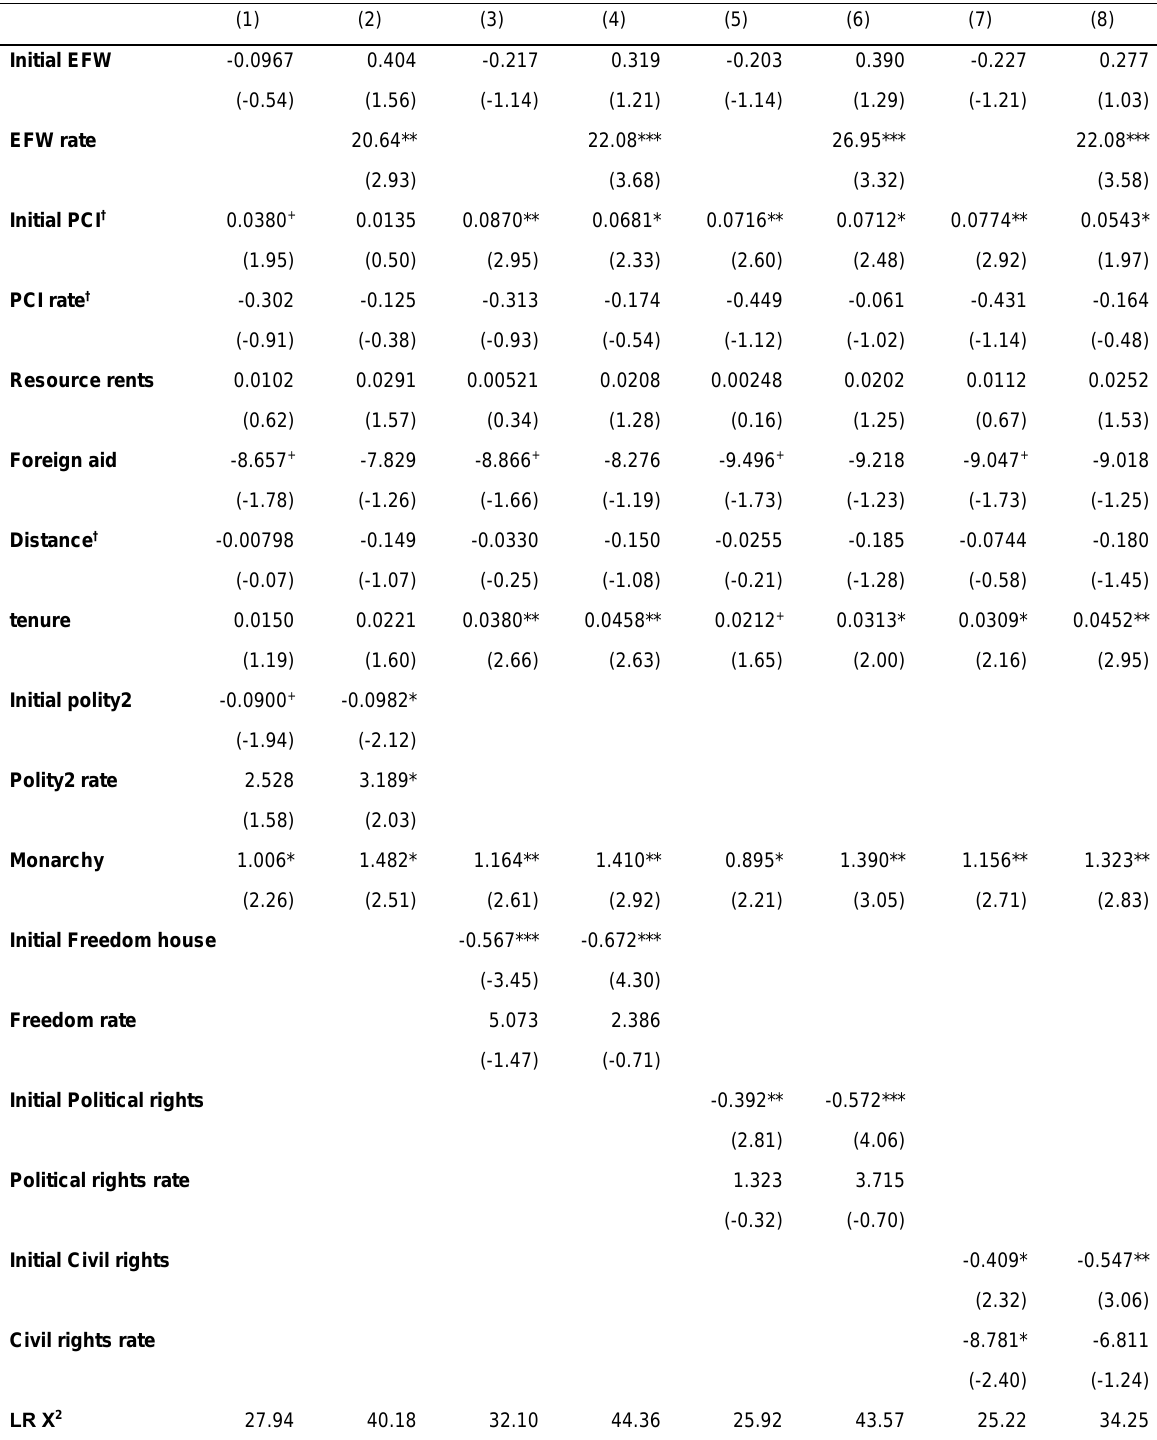
Table 3. Effect of Economic and Political Institutions on the Wealth of Leaders (Ordered Probit